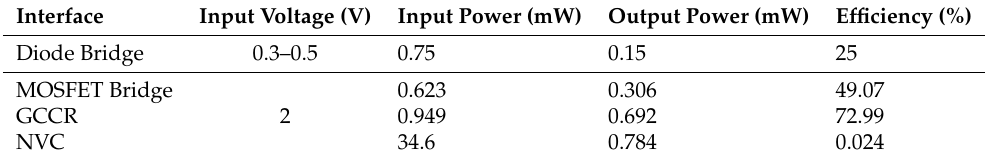
Table 2. Influence of the rectifier type on the performance of State of the Art P-SSHI for RC loads